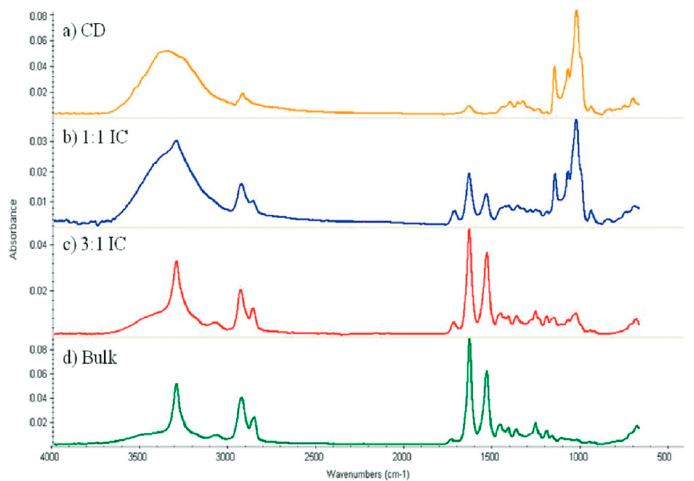
Figure 4. Fourier transform infrared (FTIR) spectra for ( a ) α –CD, ( d ) 600,000 g/mol nylon-6, and their ( b ) 1:1 stoichiometric and ( c ) 3:1 (n-s) α –CD ICs.